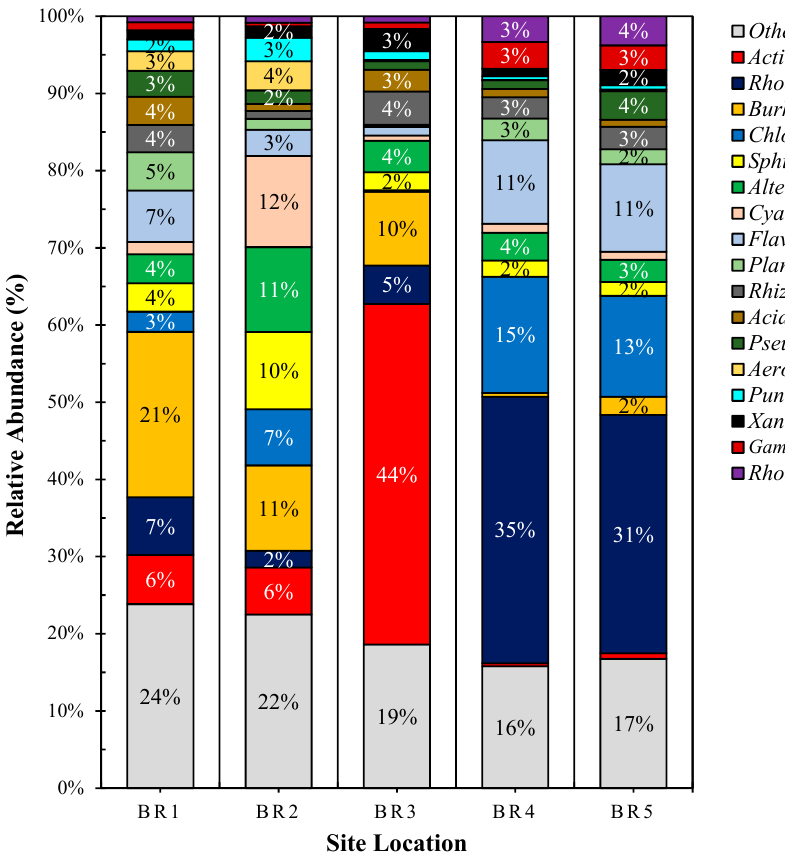
Figure 2. Bacterial order (top 17) profile of the BR sample sites. Note: ‘others’ represent orders less than 2% of the total sequence abundance.